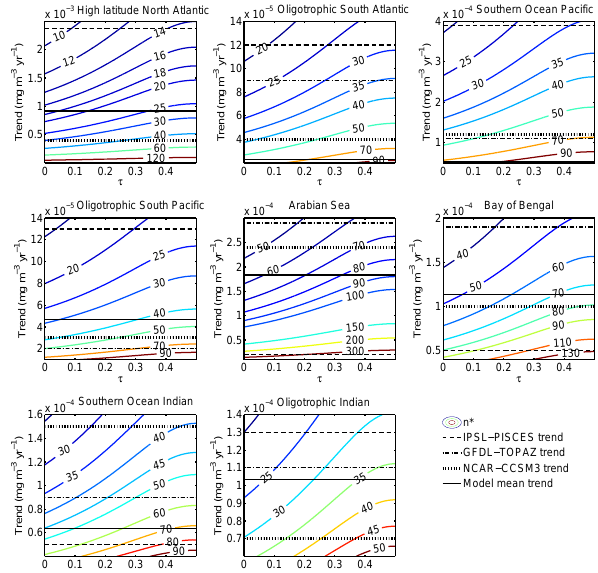
Fig. A4. Number of years of observations ( n ∗ ) necessary to de- tect a trend in satellite monthly ocean chlorophyll in eight different biomes according to the magnitude of the trend and of the fraction of data before the discontinuity ( τ ). The standard deviation and au- tocorrelation used in the calculations were estimated from SeaWiFS data from 1998–2007. The range for the trend magnitude was ob- tained from three biogeochemical models and these magnitudes (in absolute value) are shown on the figure as well as the model mean trend. We present the fraction of data before the discontinuity be- tween 0 and 0.5 only since the results are symmetric. For example, the number of years necessary to detect a trend of the same magni- tude will be the same if the discontinuity occurs after 25% or 75% of the data was collected, assuming a linear